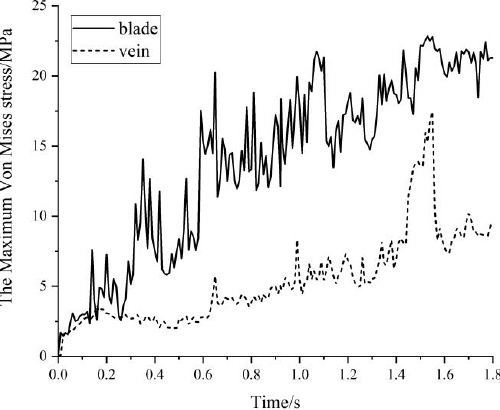
Figure 7. Curve of the maximum Von Mises stress of blade and vein.